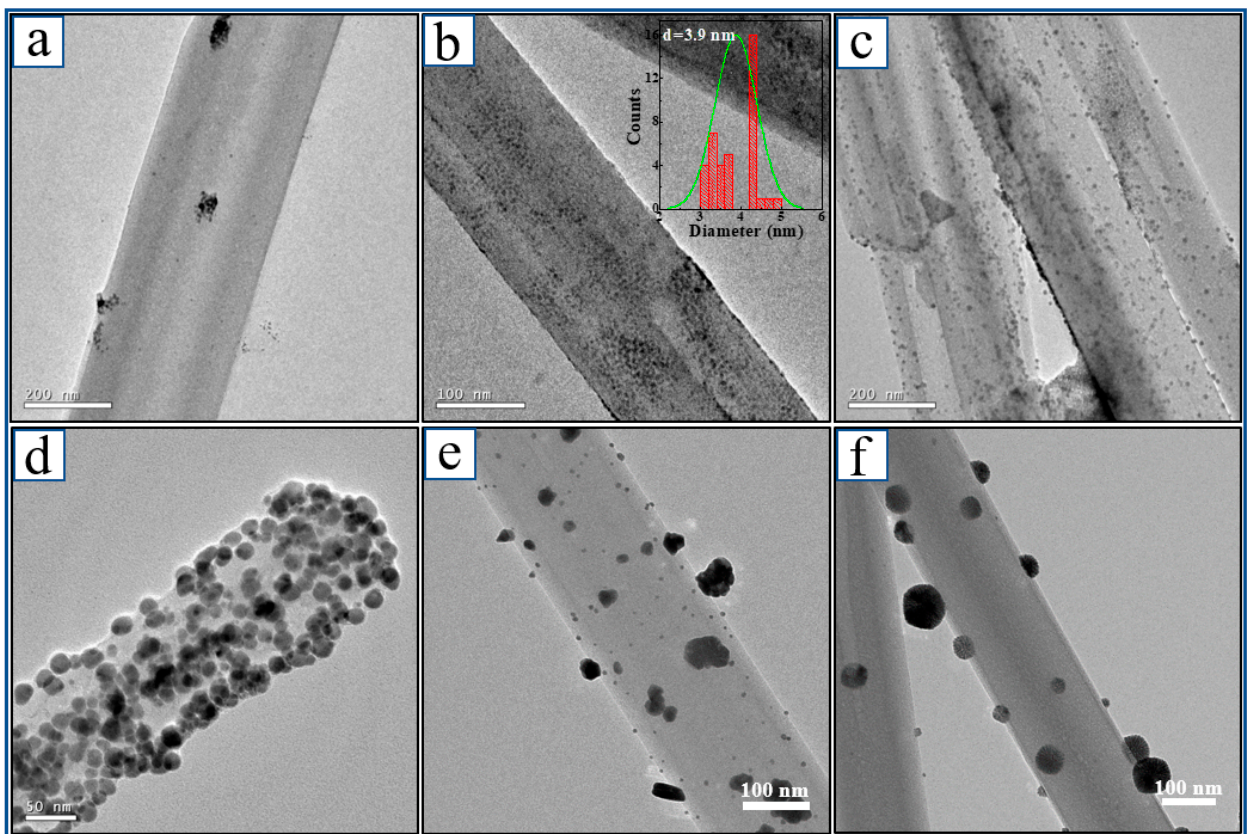
Figure 3. TEM image of one-dimensional M-HW composite: ( a ) 5.6% Ag-HW; ( b ) 12.3% Ag-HW; ( c ) 23% Ag-HW; ( d ) 45% Ag-HW; ( e ) 16.7% Au-HW; ( f ) 9.1% Pd-HW.